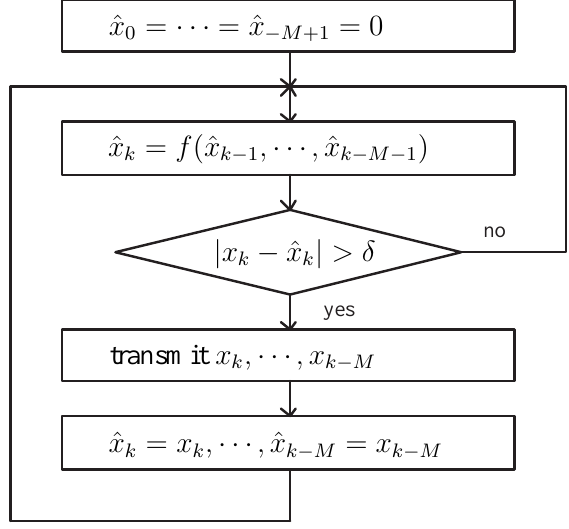
Figure 3 . Transmitter Algorithm in Sensor Nodes ( x